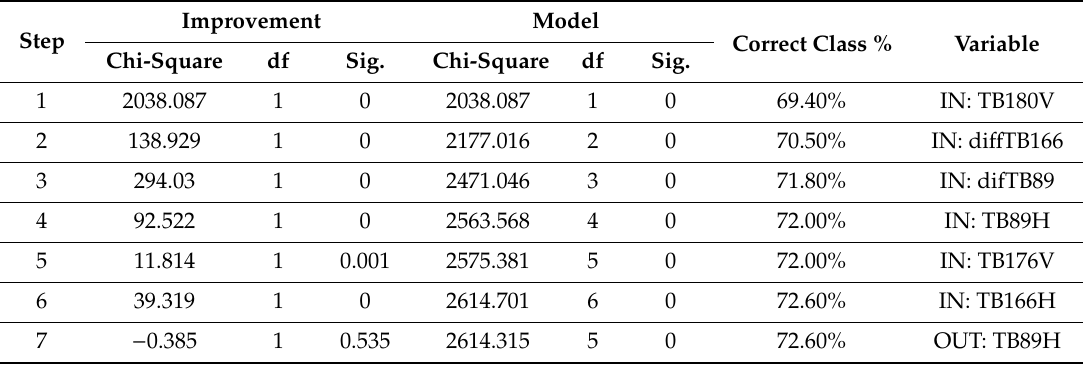
Table 7. Forward stepwise logistic regression model performances for the final model. Each step shows results from the logistic regression model with a new additional predictor variable.